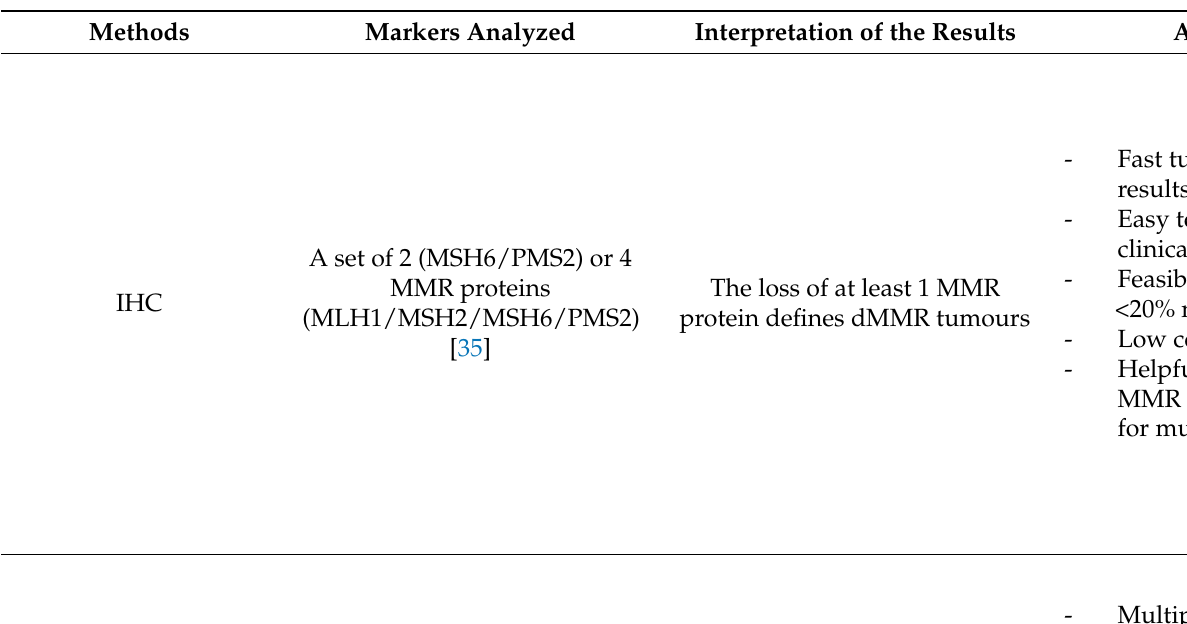
Table 1. Characteristics of the standard reference methods for MSI/dMMR